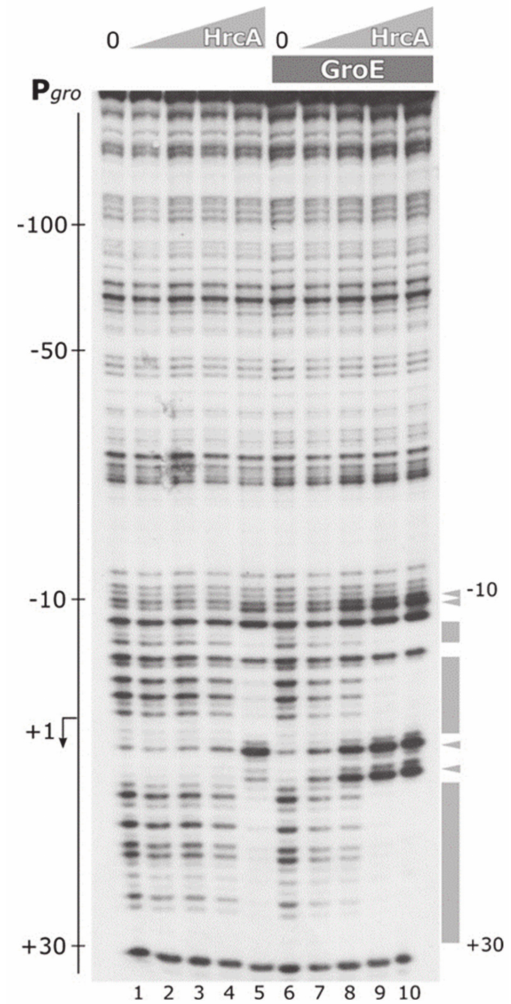
Figure 6. DNase I footprinting analysis of HrcA binding to P gro promoter in the presence or absence of GroEL/GroES complex. Protein–DNA mixes were incubated for 15 min at 25 ◦ C (the same protein concentrations as the experiment of Figure 5B) in the presence of a two-fold molar excess of GroESL (lanes 6–10) or GST as control, (lanes 1–5) with respect to the highest HrcA concentration, before DNase I digestion. On the left of the autoradiograph, the numbers refer to the positions with respect to the transcriptional start site (indicated by a bent arrow). Grey boxes on the right of the autoradiographic film represent the regions of DNase I protection; black arrowheads indicate bands of hypersensitivity to DNase I digestion and numbers indicate the positions delimiting the HrcA binding site. Grey triangles indicate increasing concentrations of HrcA; 0, no HrcA protein added; dark grey box, a constant amount of